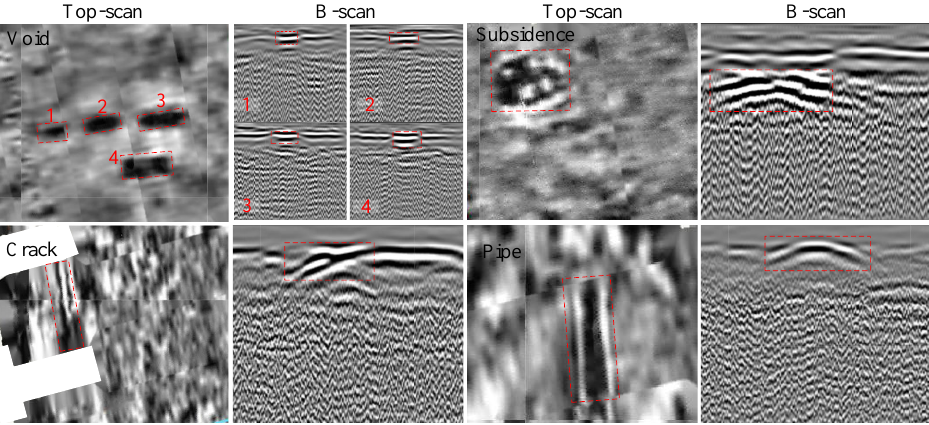
Figure 13. GPR B-scan and Top-scan images from the field